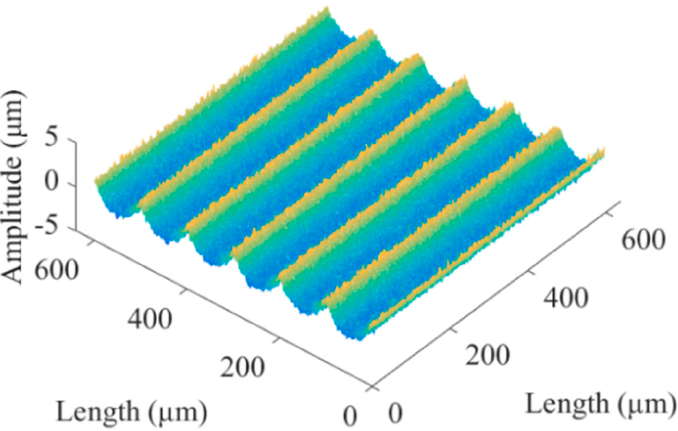
Figure 4. Simulated microgroove surface.